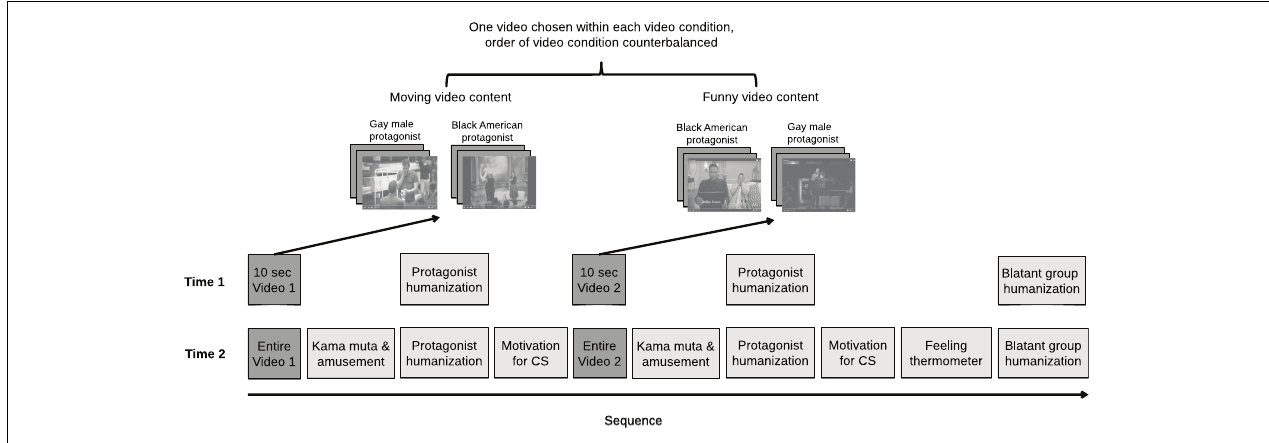
FIGURE 2 | Pictorial representation of the pre and post-test experimental design in Study 2.